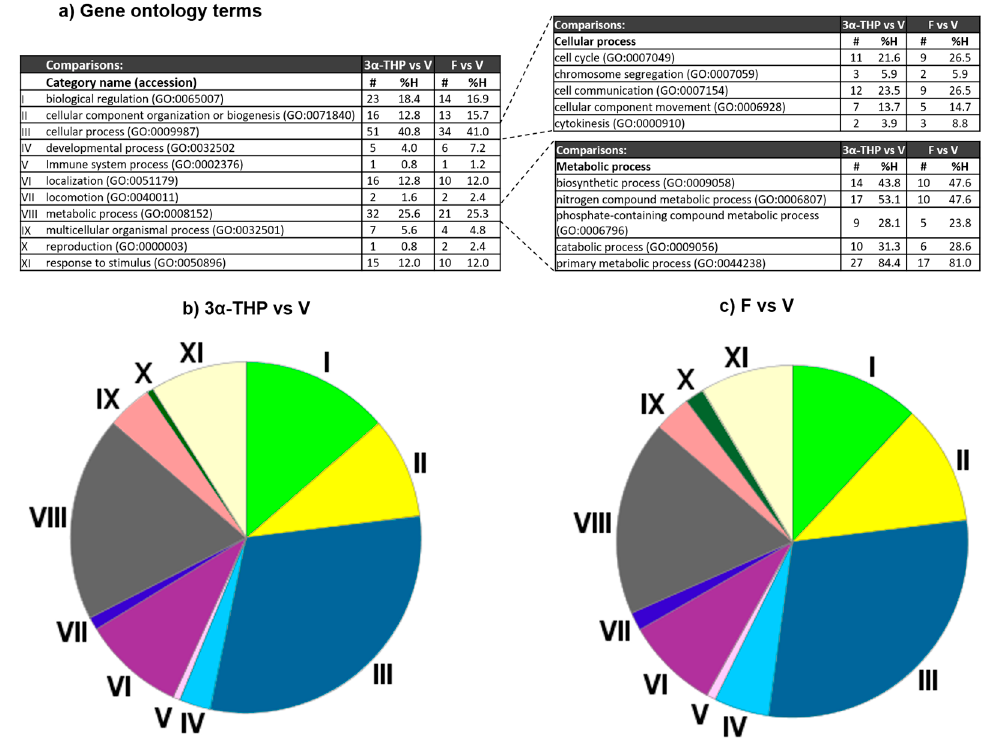
Figure 2. Enrichment analysis of the group of genes regulated by 3 α -THP and F. The proteins coded by the differentially expressed genes after 3 α -THP and F treatments were analyzed with PANTHER. ( a ) The diverse biological processes (categories) in which the gene products participate are shown in the left table. As the categories of cellular process and metabolic process were ones of the most enriched by 3 α -THP and F, we performed a second analysis to determine sub-categories. In the three different tables, the number of genes in each category (column # ), and the percentage of gene hits against the total number of genes (column %H) for each treatment are indicated. ( b , c ) The pie charts show the enriched categories (marked with roman numbers) for the two treatment comparisons.